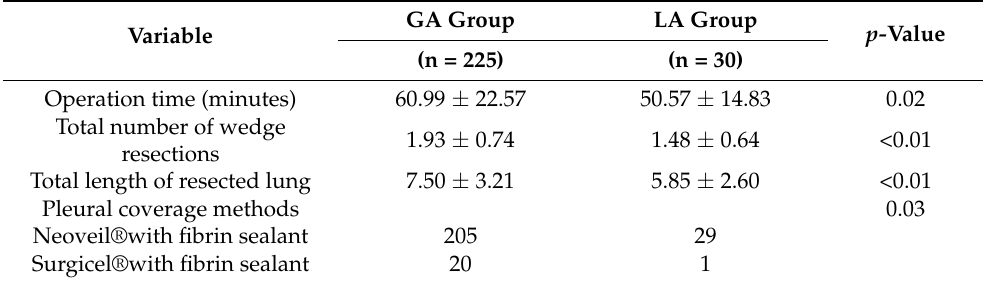
Table 4. Intraoperative details.